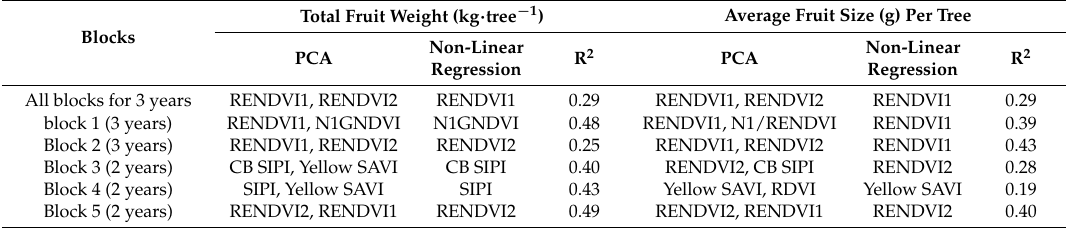
Table 2. Best vegetation indices (VIs) for all blocks and for each block for average fruit size (g) per